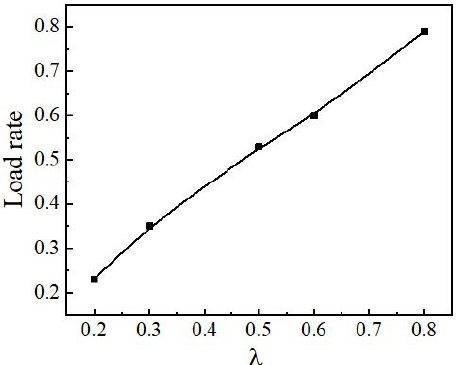
Figure 17. The load rate curve with different λ.